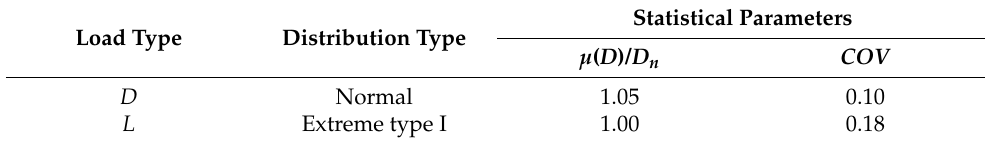
Load Type Distribution